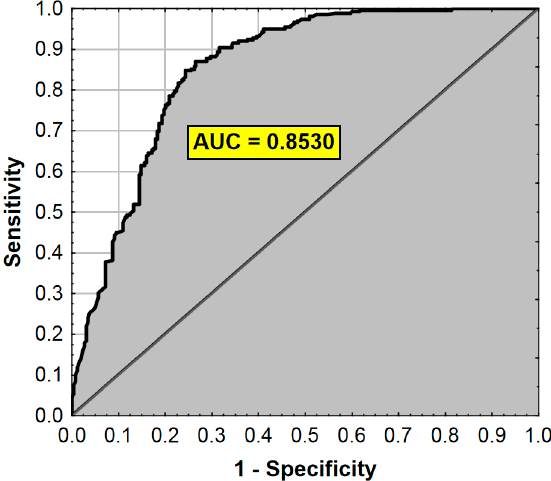
Figure 3. ROC curve and AUC value for the regression model from Table 8. AUC—Area Under the Curve (measure of diagnostic accuracy).